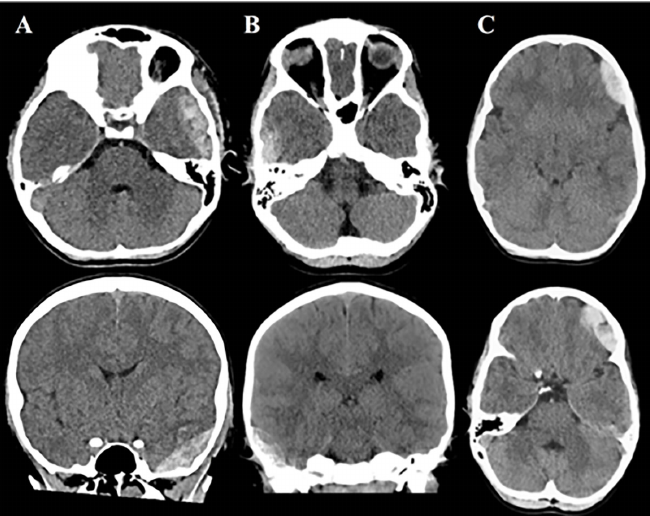
Figure 3. Computed tomography images of three hematomas not detected by the handheld brain